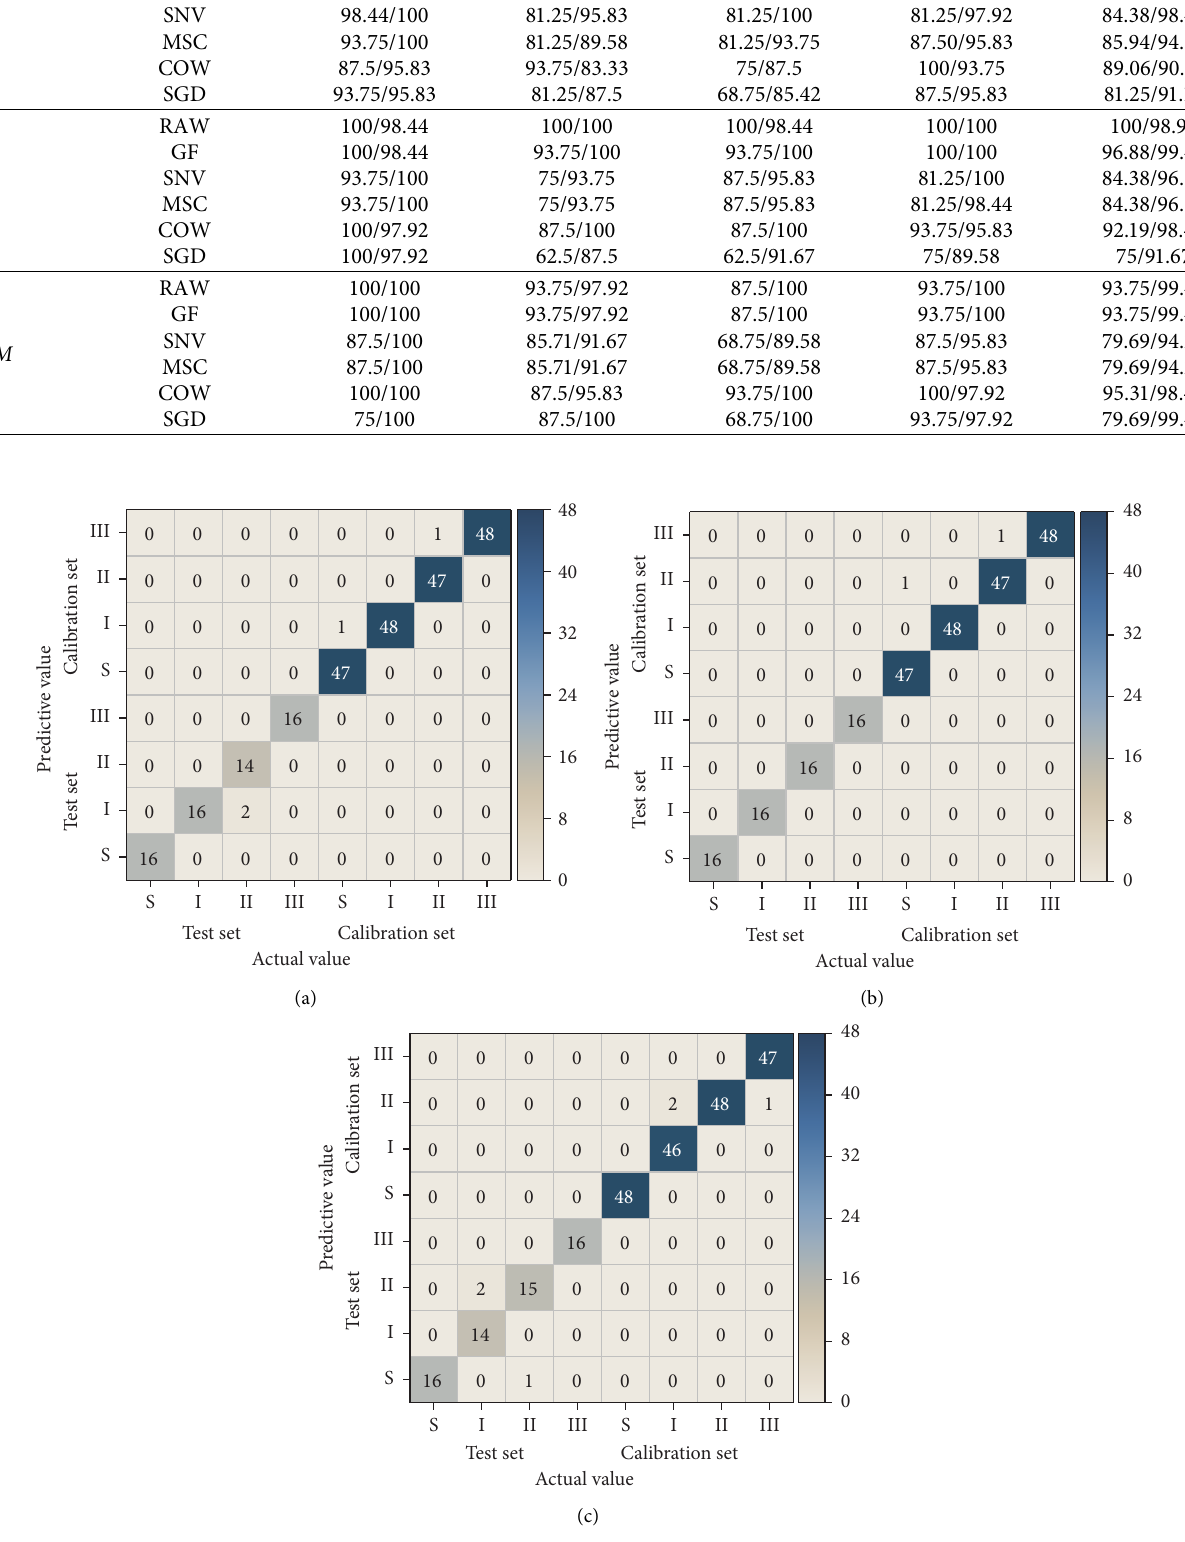
Figure 5: Confusion matrix of the discriminant results of the optimal SVM model based on R , A, and K - M spectra. Confusion matrix of discriminant results of the (a) R-GF-SVM model, (b) A-RAW-SVM model, and (c) K-M-COW-SVM